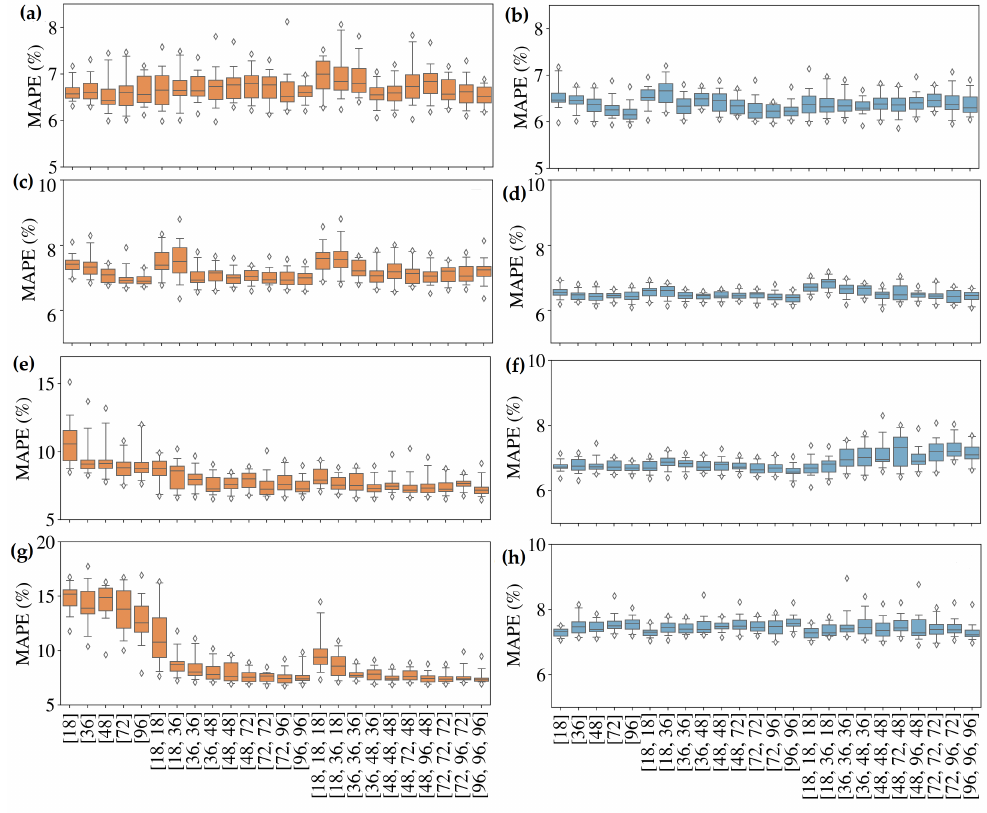
Figure 4. MAPE of the 20 simulations for each combination of nodes and layers of the ts 2 with set of lags 1. The results for the FFNN with 1 h, 6 h, 24 h and 168 h of horizon are reported in panel ( a , c , e , g ), respectively. Whereas, the results for the LTSM with 1 h, 6 h, 24 h and 168 h of horizon are reported in panel ( b , d , f , h ), respectively.